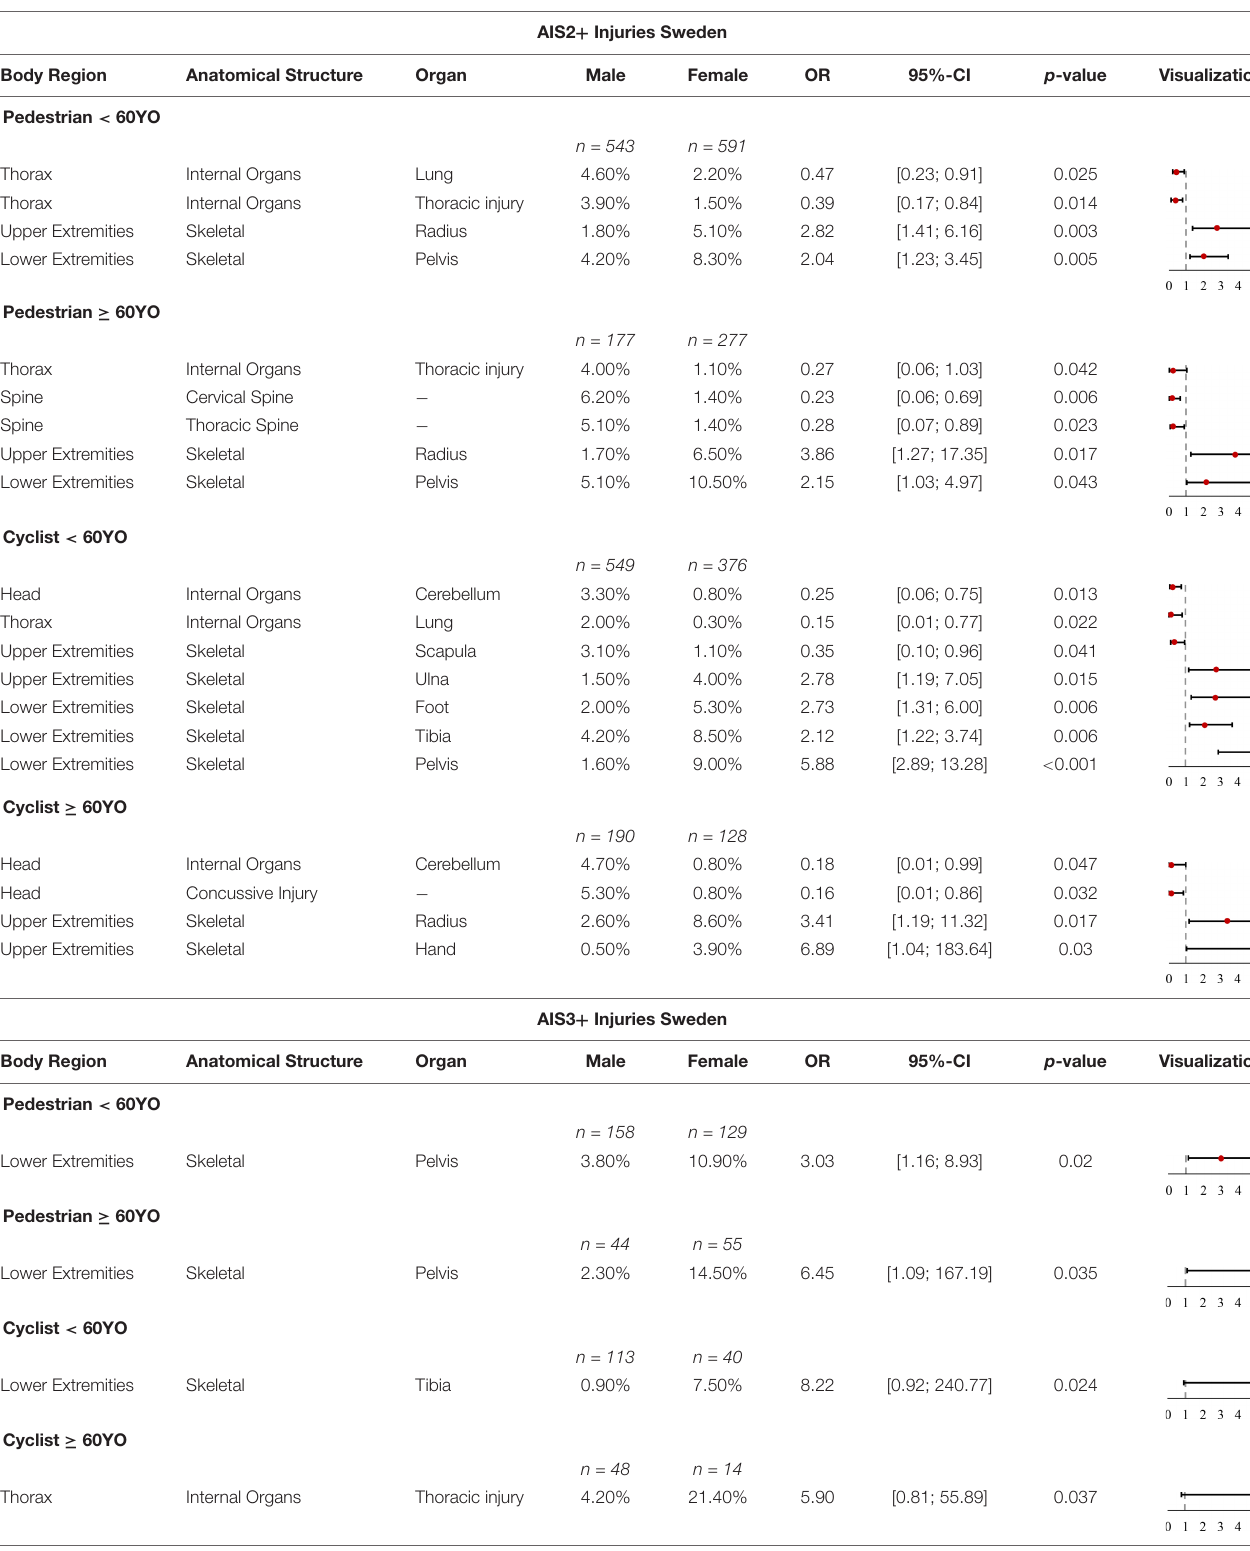
TABLE 9 | Share of AIS2 + and AIS3 + injuries with significant differences, OR and p -value in Sweden for pedestrians and cyclists < 60YO and ≥ 60YO. AIS2 + Injuries